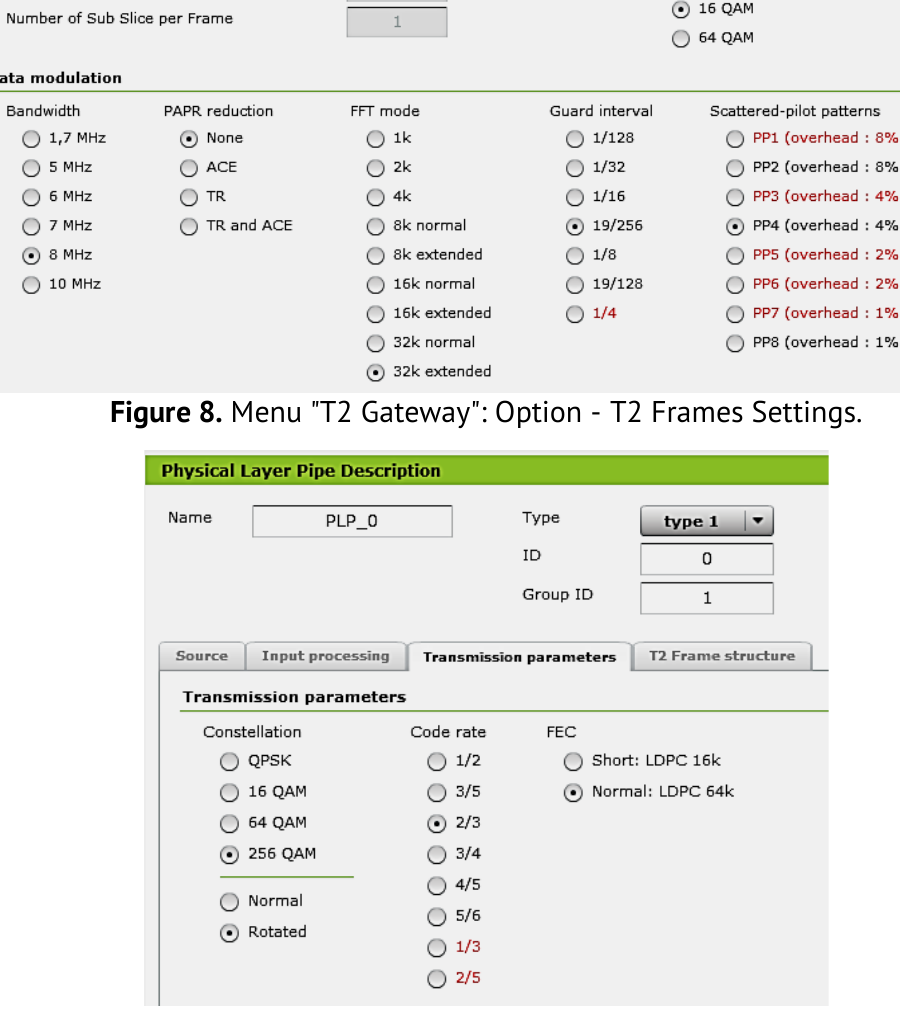
Figure 9. Menu "T2 Gateway": Option - Physical Layer Pipe Description/Transmission